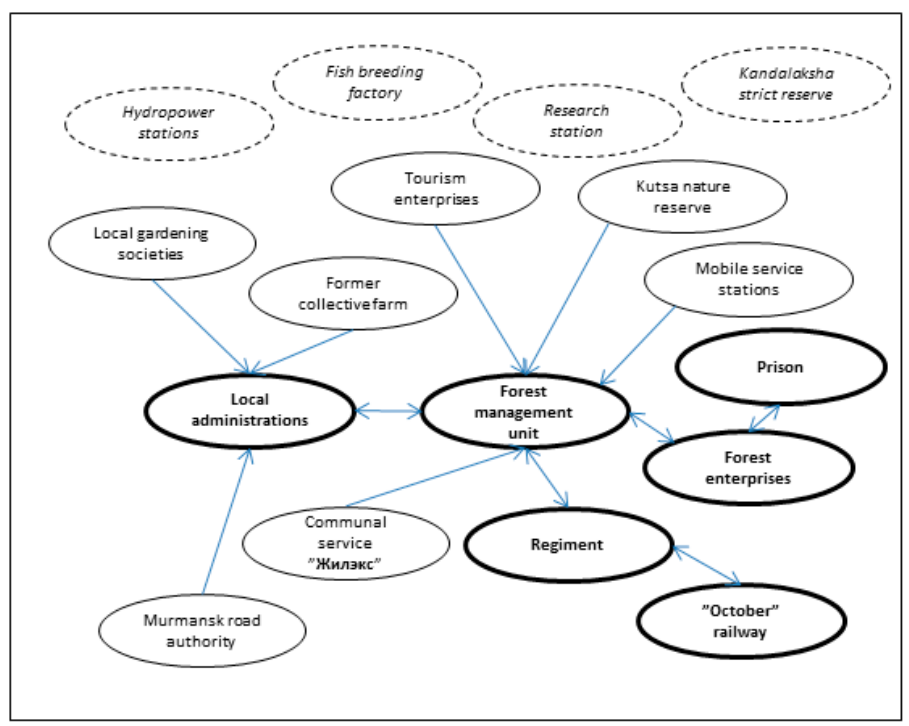
Figure 5. Management interactions between landscape stakeholders in the lower part of the Kovda River catchment. Bold text denotes two-way interactions, plain text one-way interactions and italics no interactions.